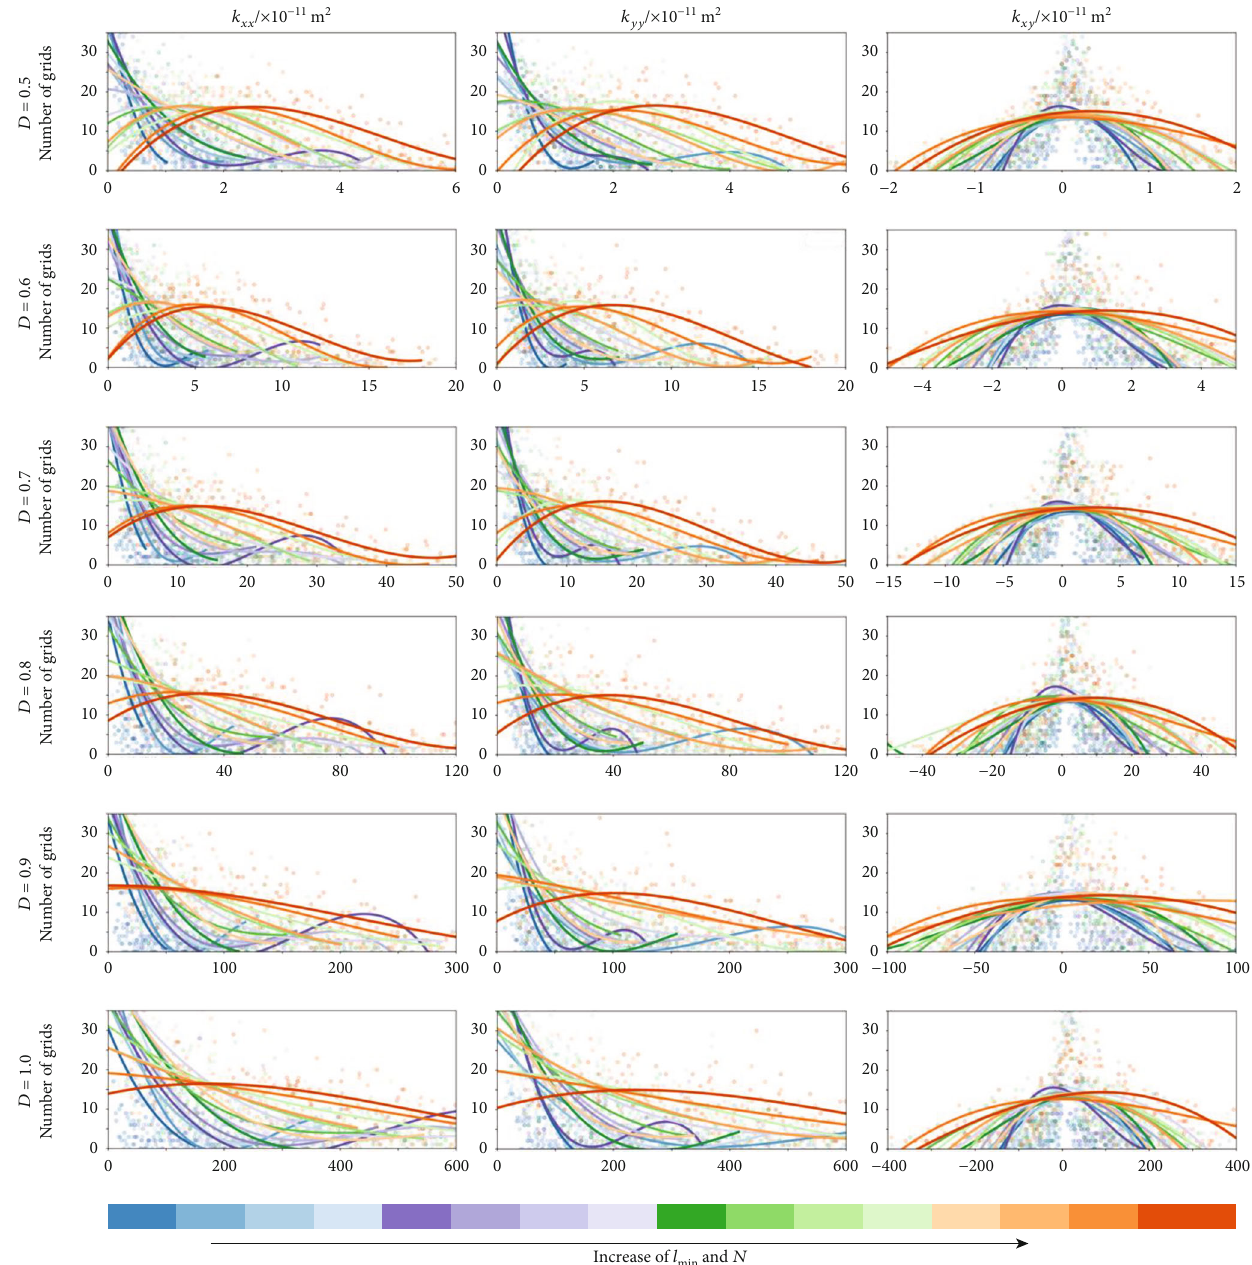
Figure 6: Fitting curves of histograms for equivalent permeability components with di ff erent aperture-length correlation exponent D and increasing l min and N